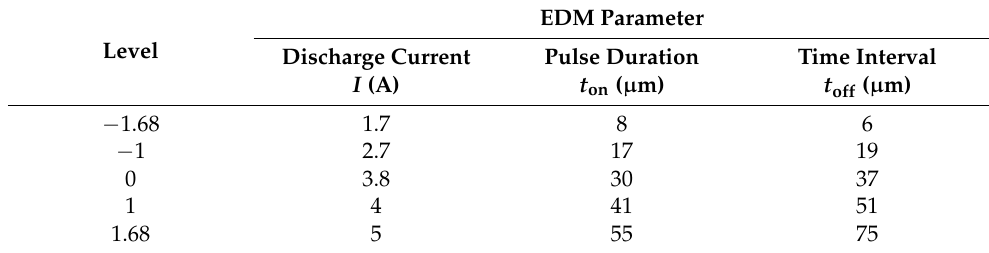
Table 4. Designed process parameters and their